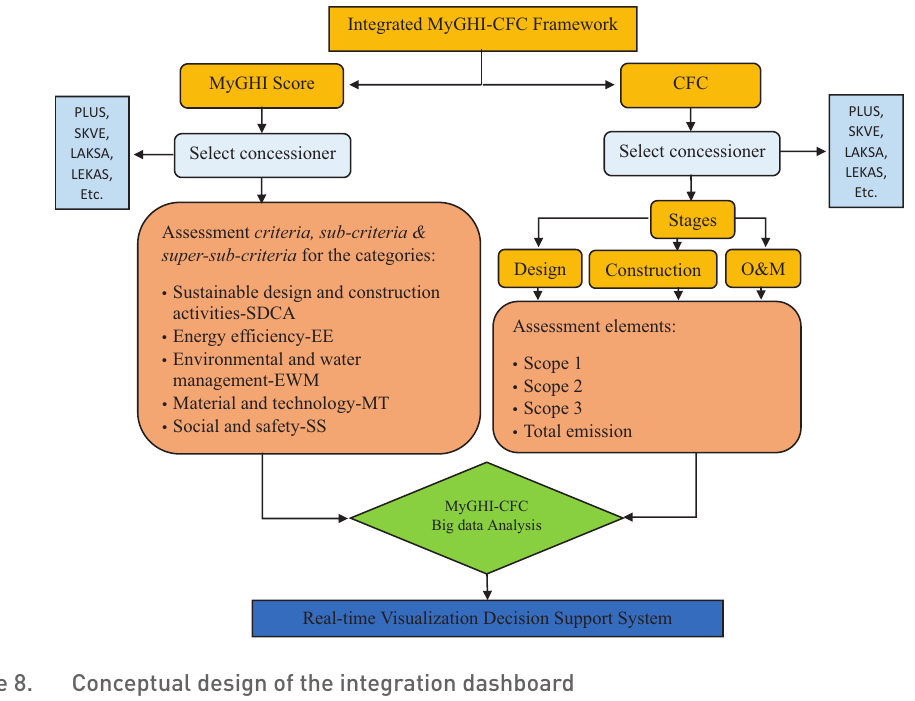
Figure 8. Conceptual design of the integration dashboard